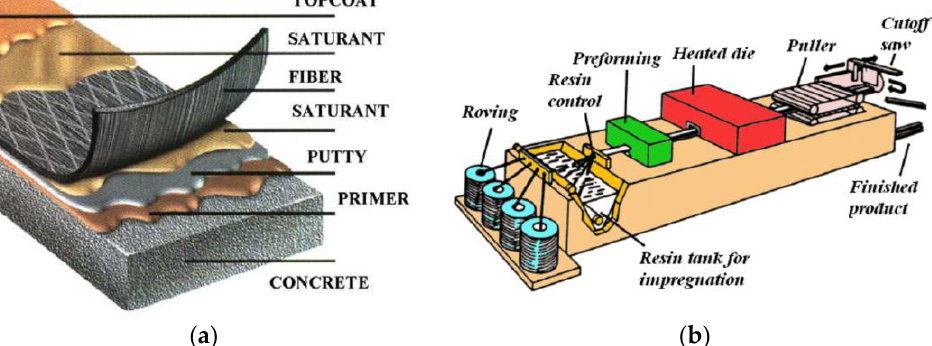
Figure 1. FRP fabrication techniques: ( a ) wet lay-up system. Adapted from Ref. [33]; ( b ) pultrusion process with resin bath impregnation. Adapted from Ref. [34].